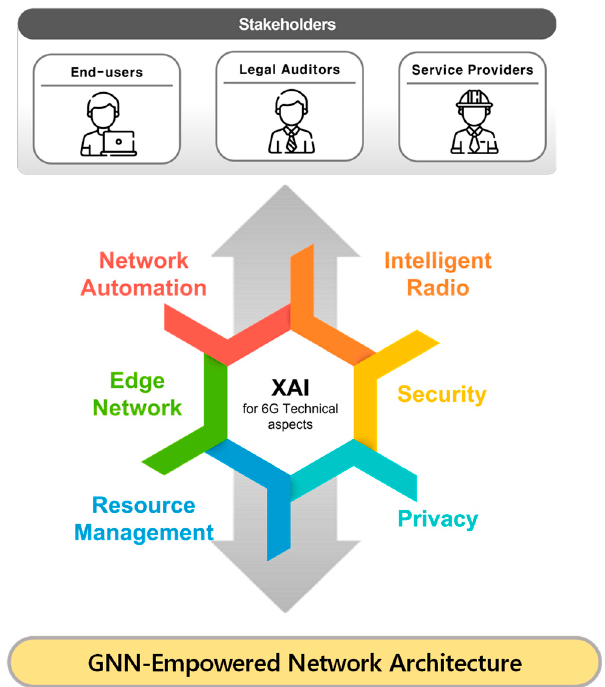
Figure 8. GNN-empowered network architecture for XAI.